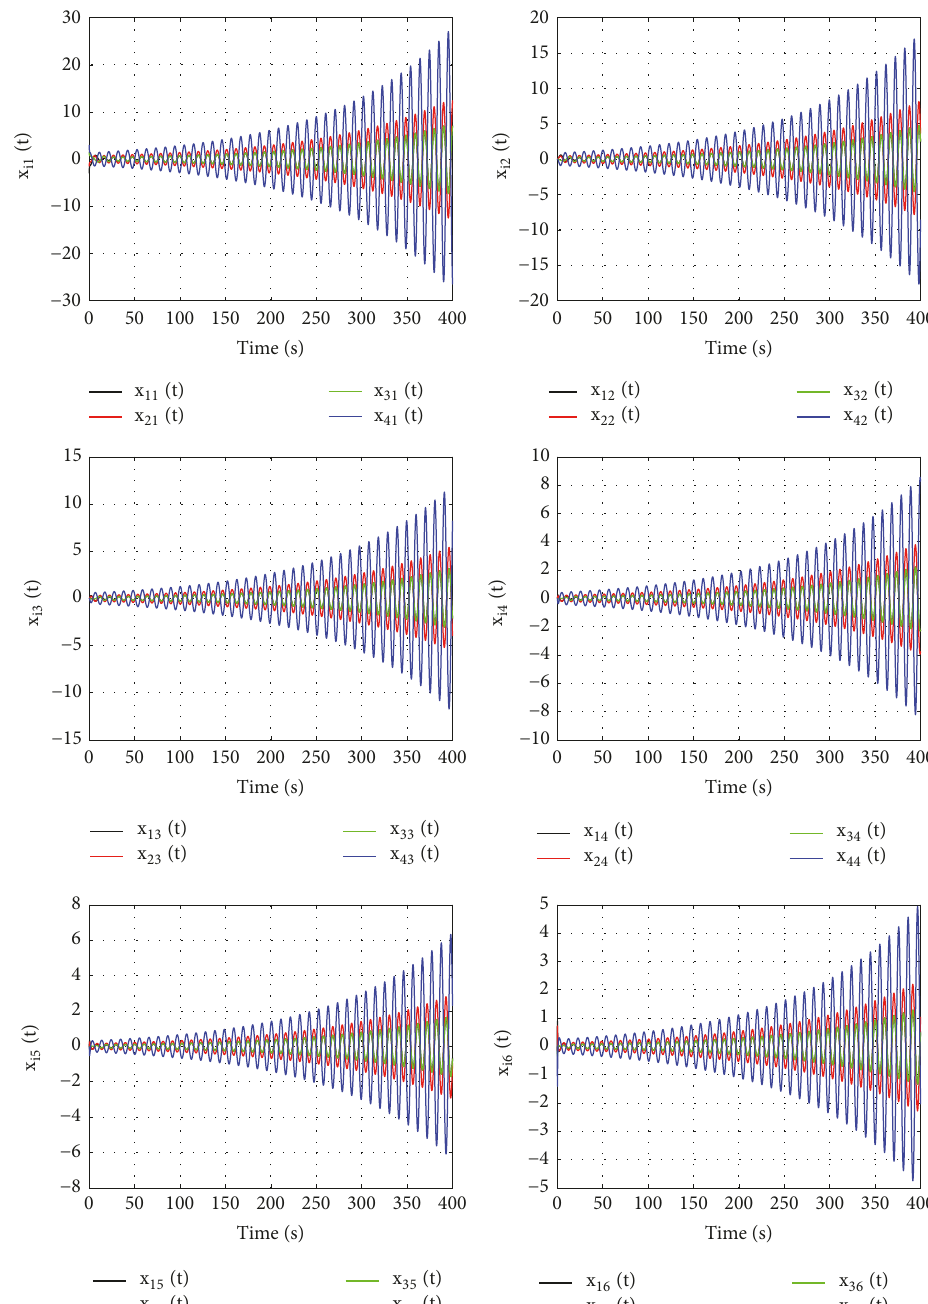
Figure 7: The trajectories of all agents’ states in the FOMAS with sextuple integral and symmetric time-delays when all 𝜏 𝑚 > 𝜏 in Example 3.